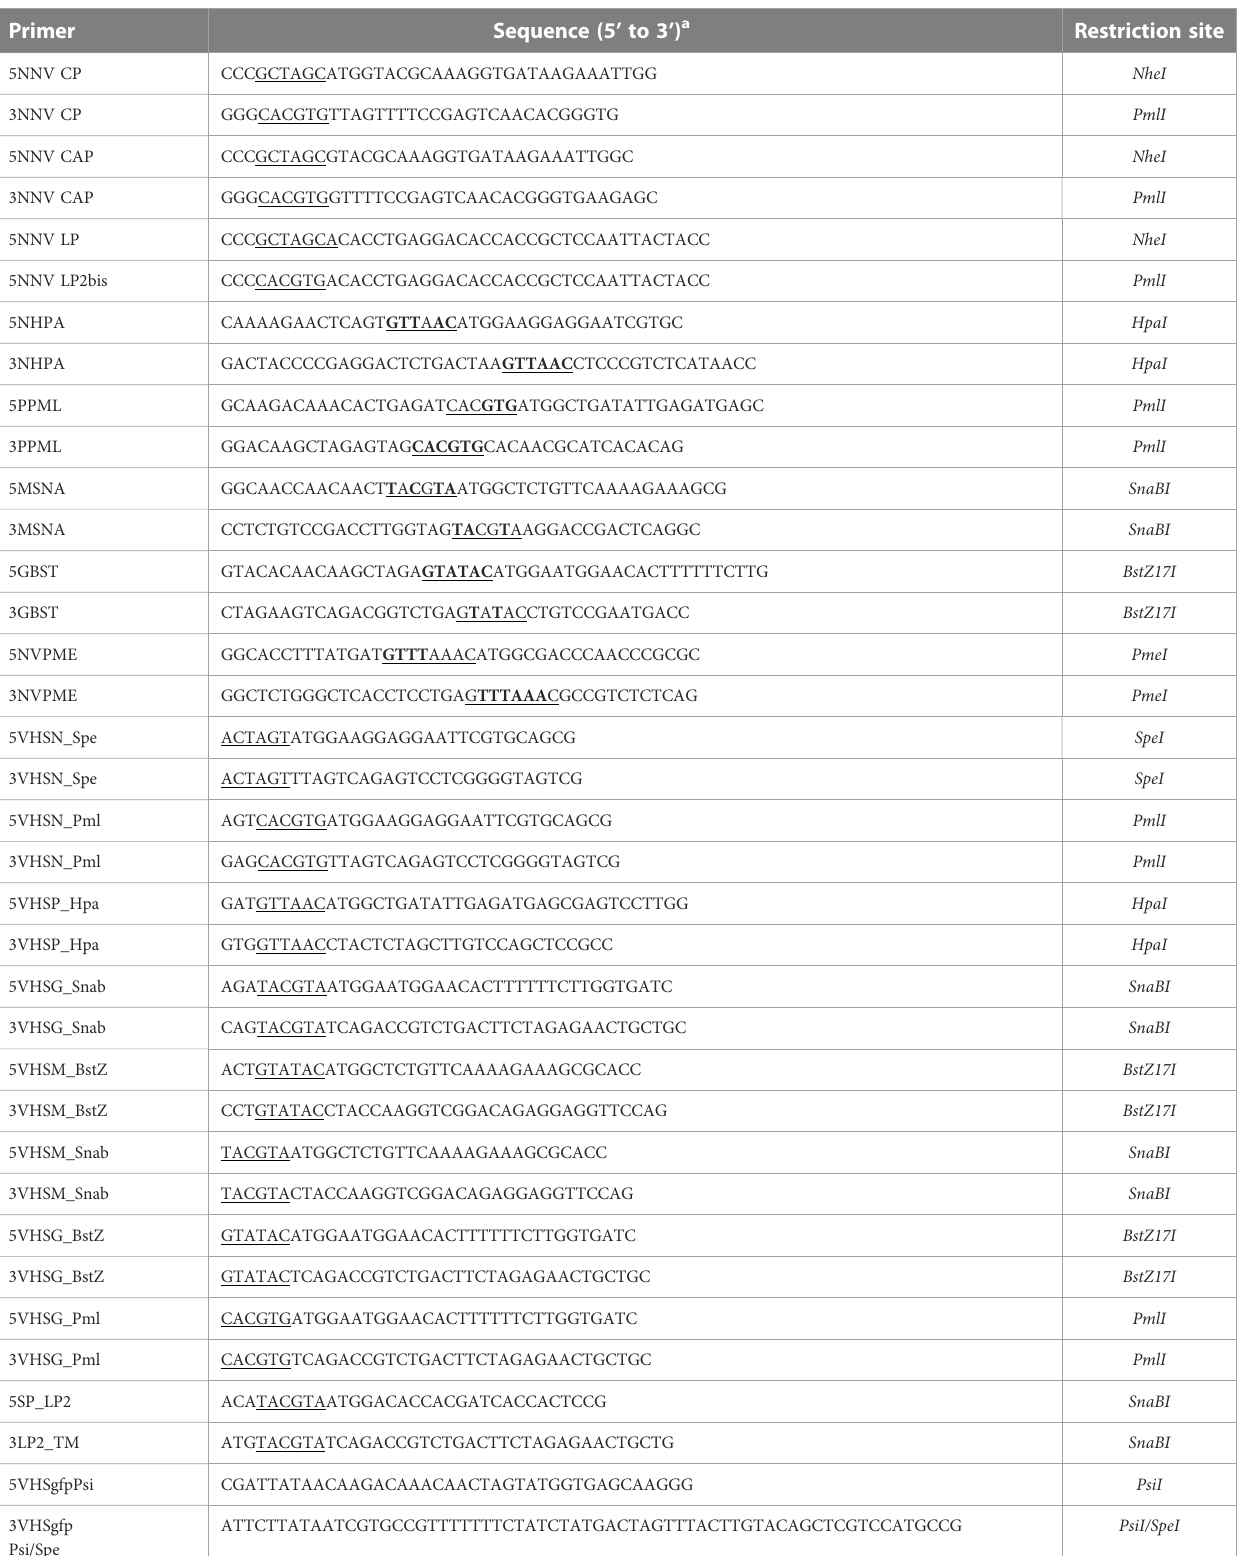
TABLE 3 Primers used in the study.